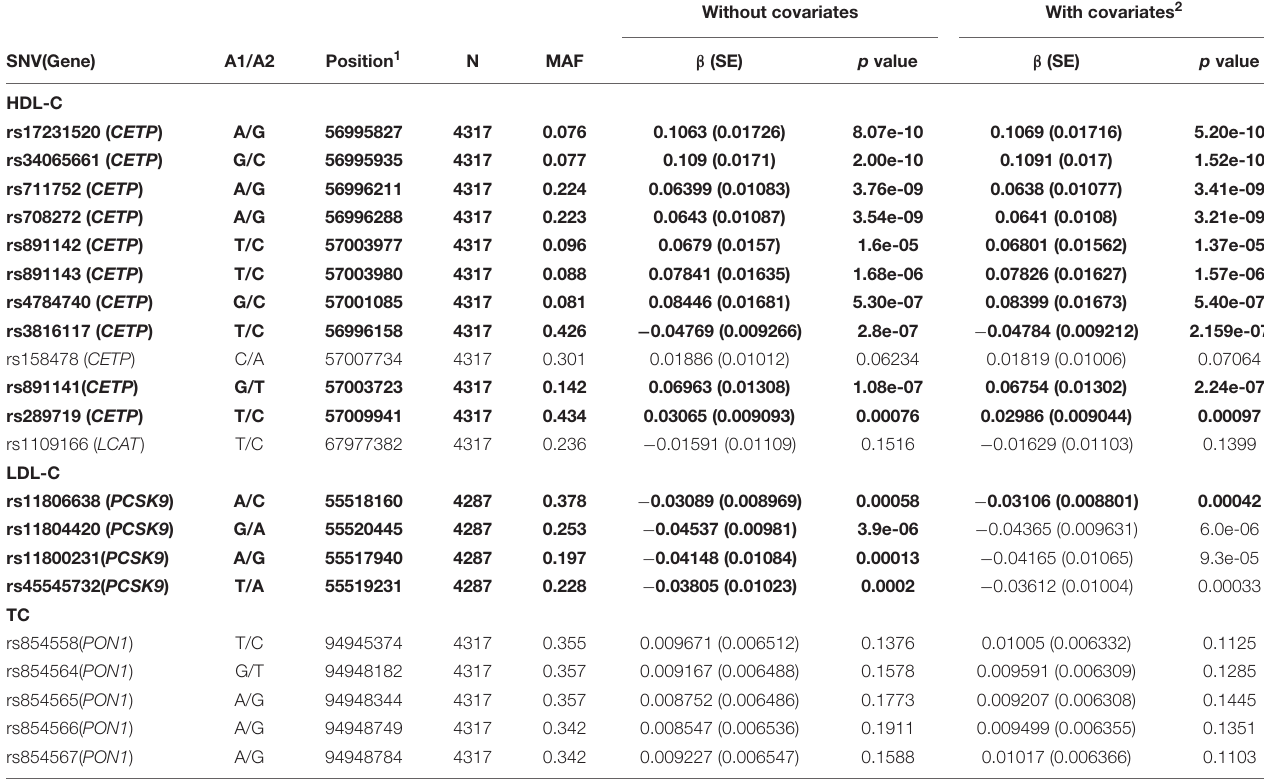
Without covariates With covariates